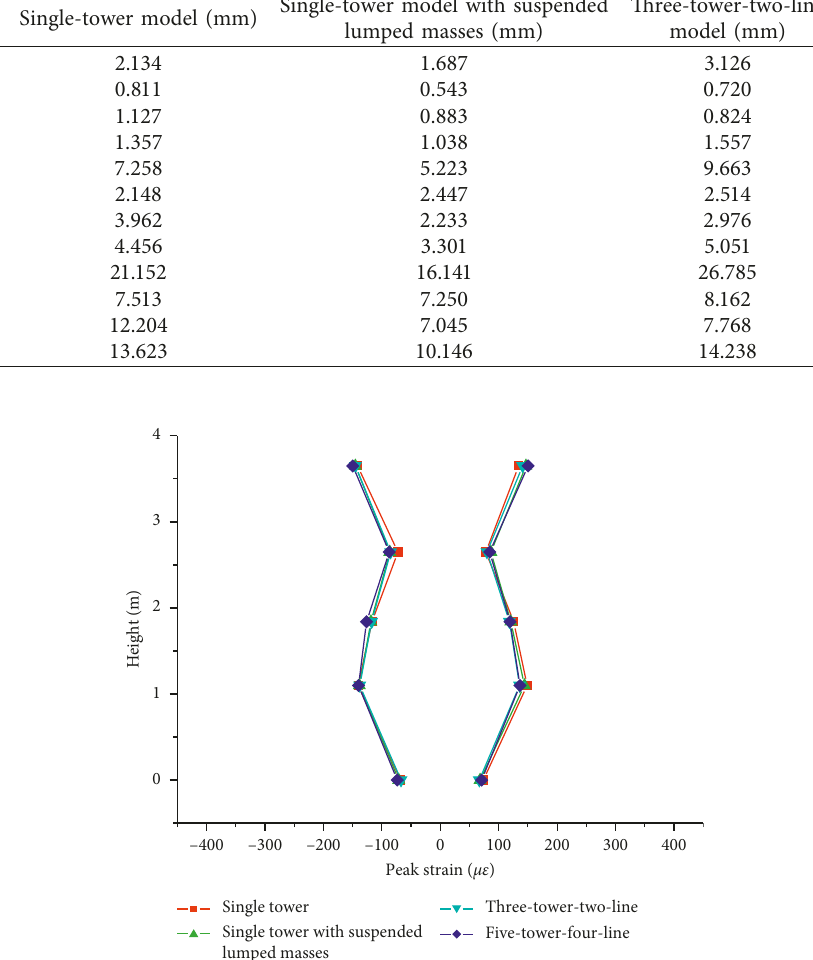
Figure 26: Longitudinal peak strain responses of the four models under a 0.21 g artificial